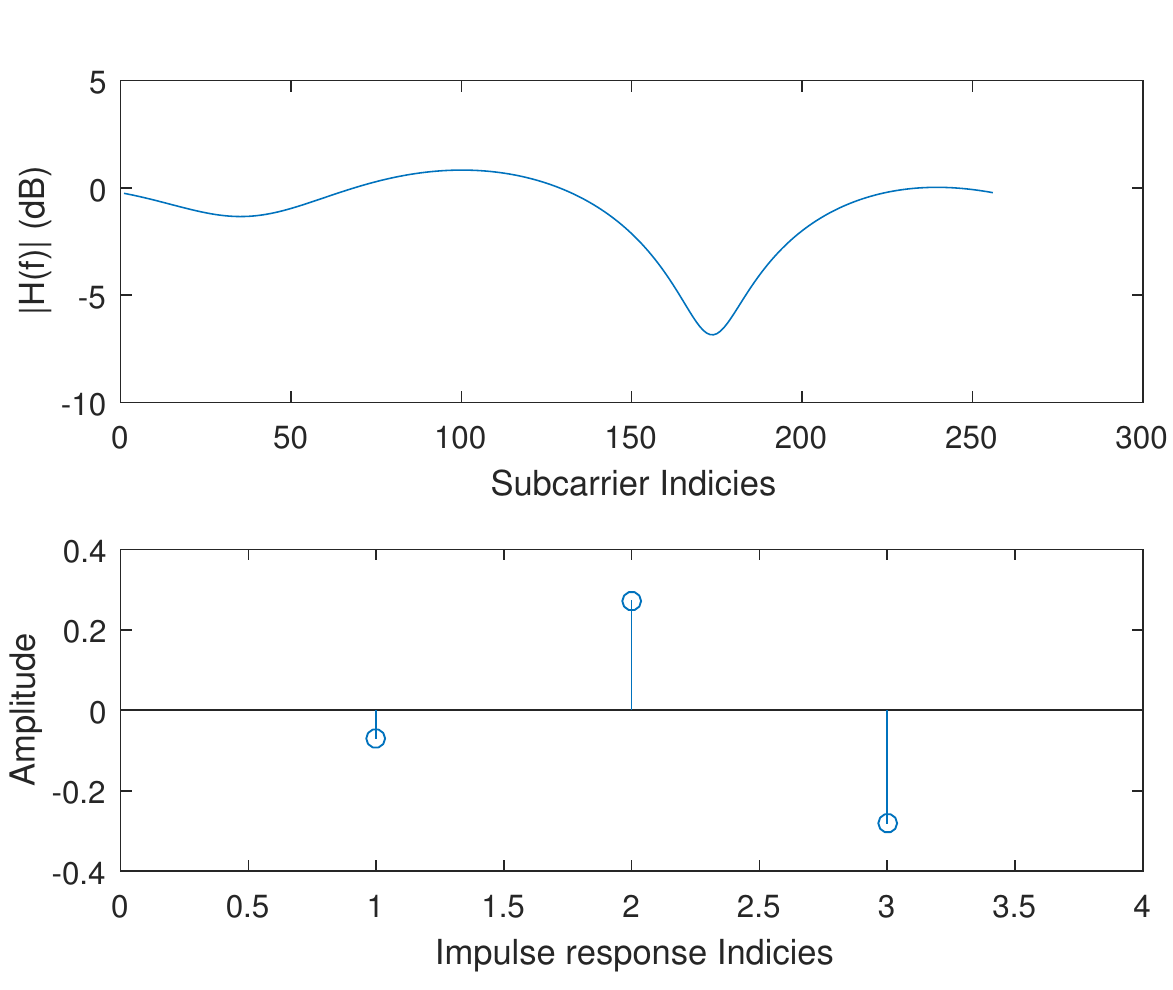
Figure 9. Channel and impulse responses ( (cid:96) h = 3 channel